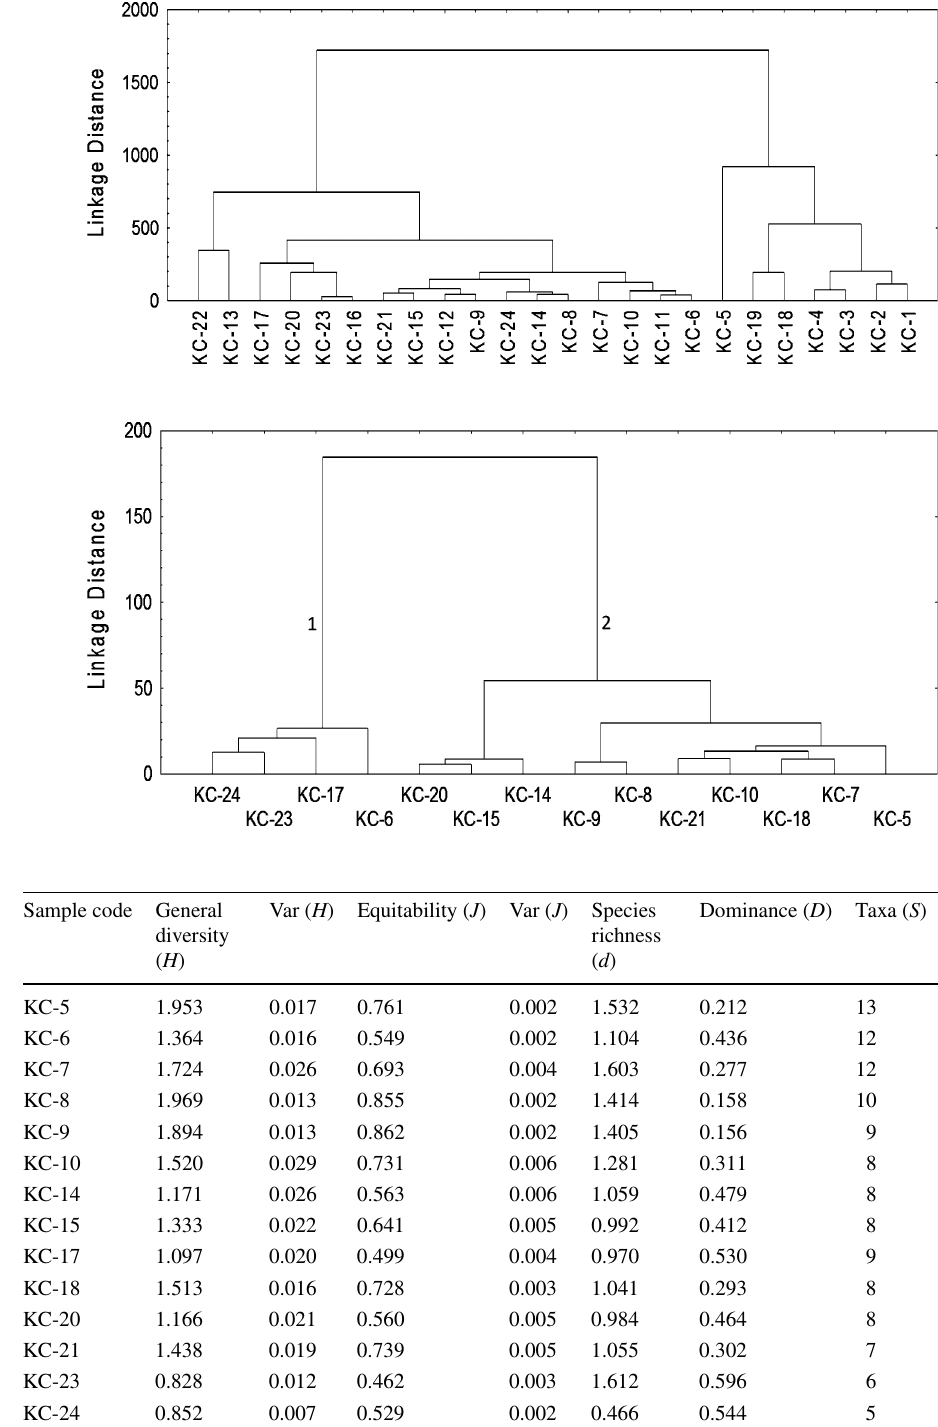
Fig. 5 Dendrogram derived from Ward’s method of 24 sites based on physical and chemical quality of Korangi creek sedi- ments